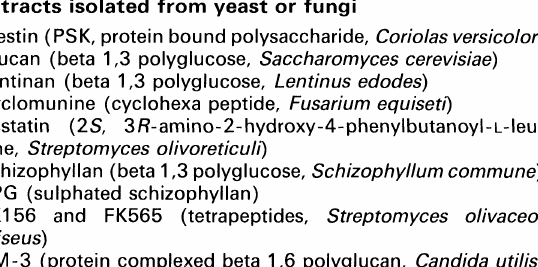
Table 6. Interrelationship of biological response mod- ifiers to cytokines Synthetic, biological, polysaccharides,